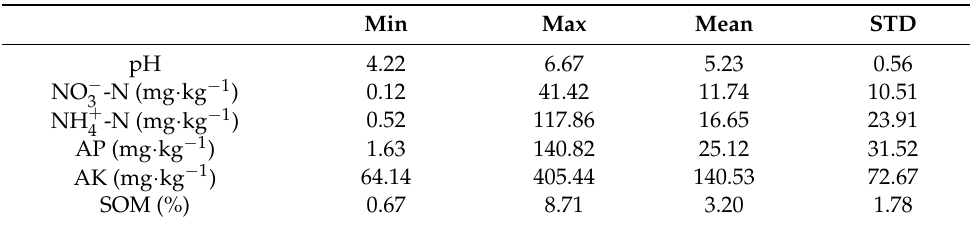
Table 1. Descriptive statistics of the soil pH and concentrations of soil nutrients.